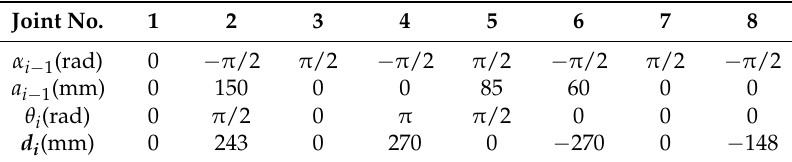
Figure 3. Experimental setup. (a) SDA5F robot and AT960; (b) The installation of T-MAC and SMR. Table 1. Denavit–Hartenberg (DH) parameters of R1.